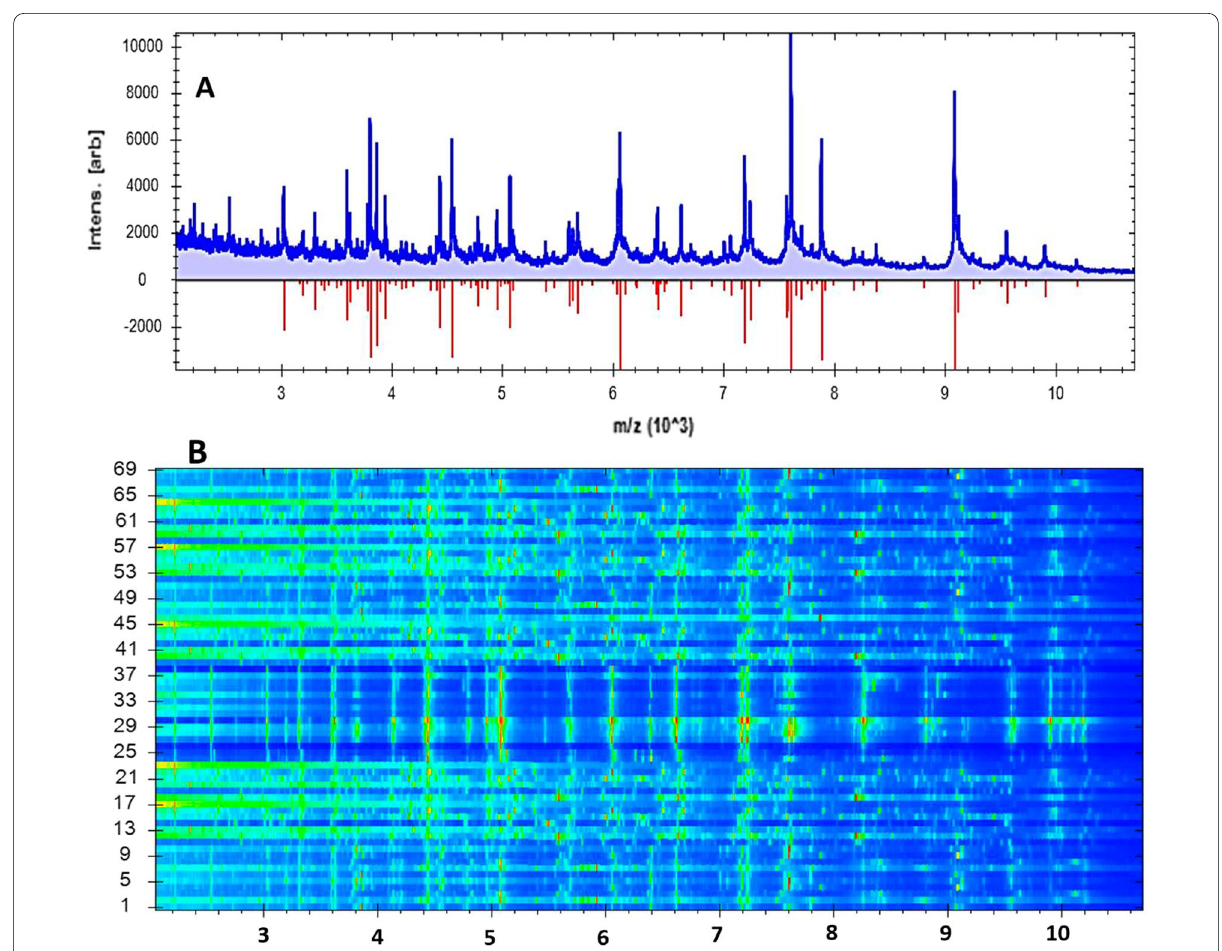
Fig. 1 Scattering of spectral proteins of 69 Pseudomonas spp.; a Spreading of peak intensities with a mass charge ratio from 2000 to 10,200 Da; b A gel view, in which the wide-ranging colour of dots represents the assembly of different